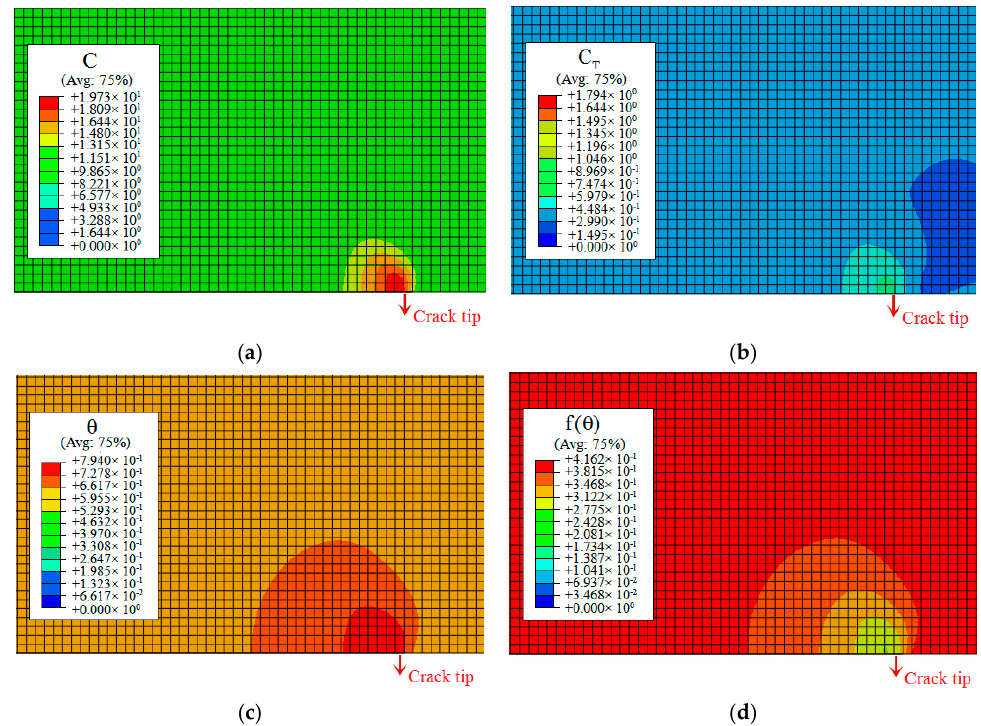
Figure 15. Results of simulations at the crack tip region for C L 0 = 8.5 ppm: ( a ) total hydrogen concentration C = C L + C T ; ( b ) trapped hydrogen concentration C T ; ( c ) coverage factor θ trend; and ( d ) TSL decreasing factor f ( θ ) trend. Avg.: averaging threshold.